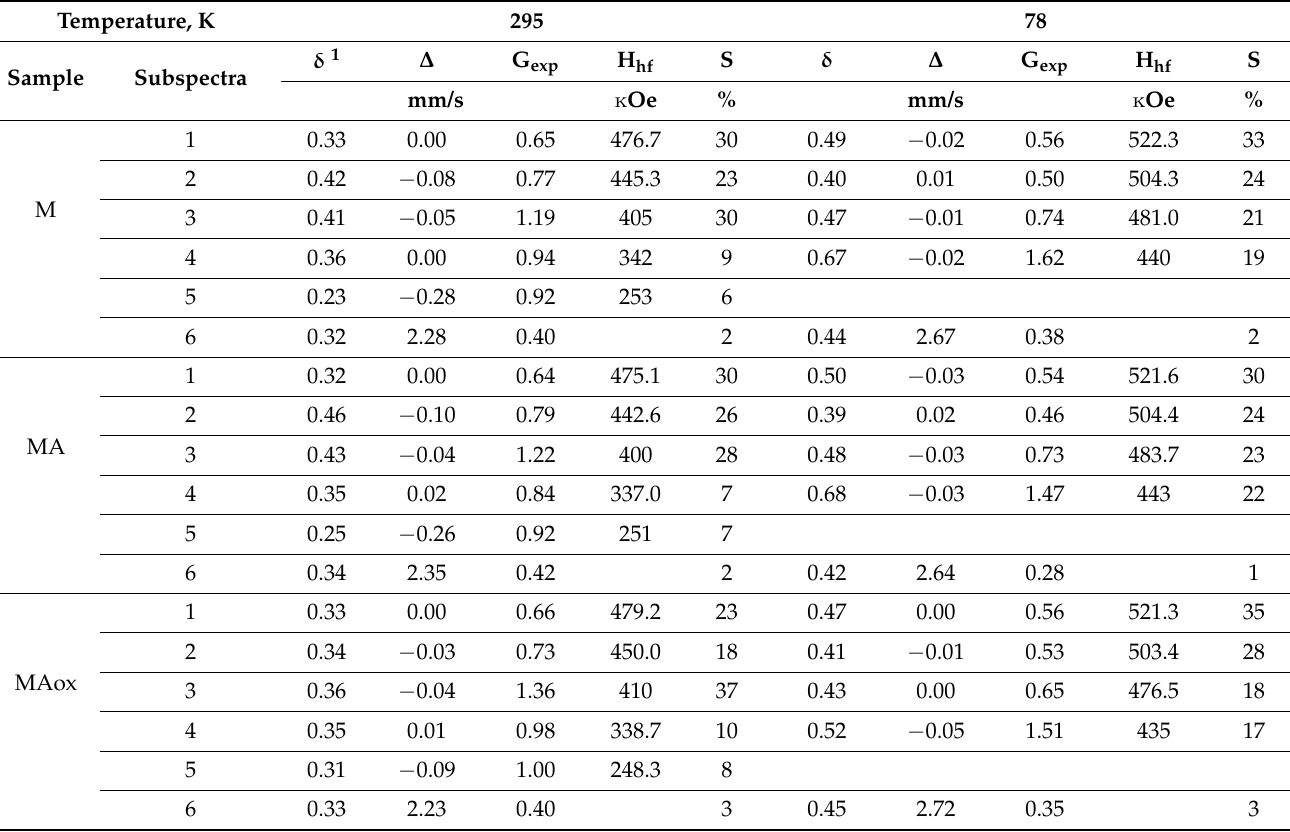
Table 2. Results of a model description of the Mössbauer spectra of samples of Fe 3 − δ O 4